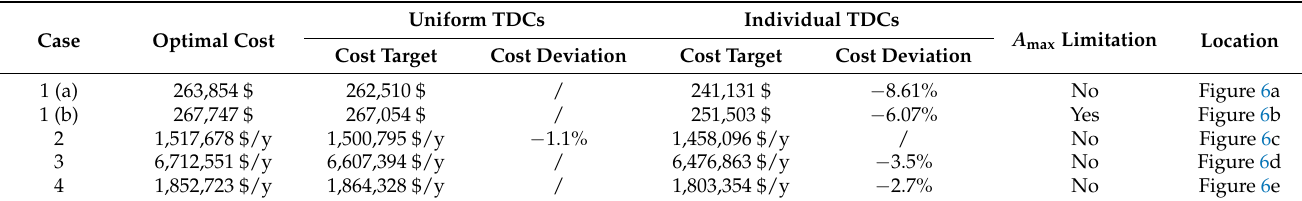
Table 3. Predictive accuracy of the optimal target value for each